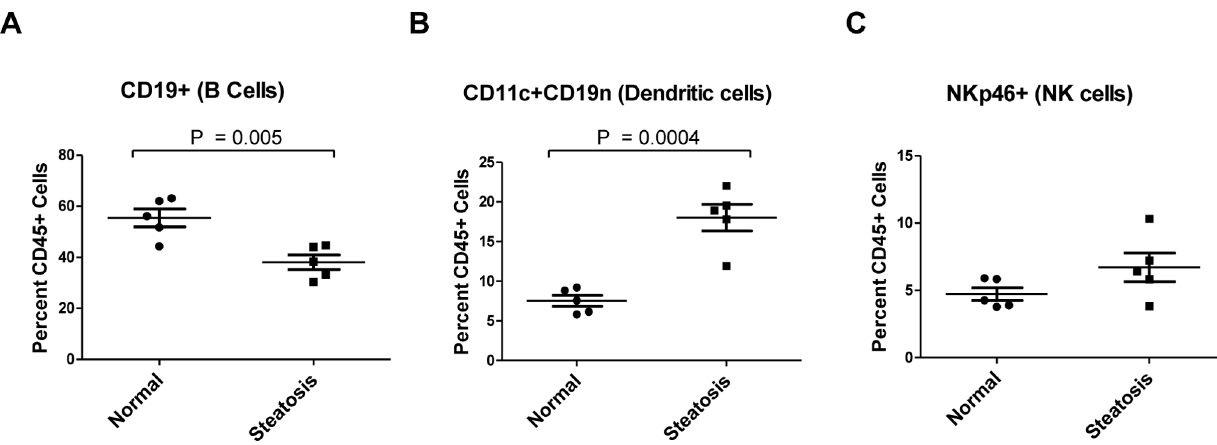
Figure 5. Changes in cell sub-populations of B cells, Dendritic cells and Natural Killer cells in steatotic livers. Isolated CD45 positive cells from normal and steatotic livers were stained for markers for (A) B cells (CD19 + ), (B) dendritic cells (CD11c + , CD19 – ) and (C) natural killers cells (NKp46 + ) before being subjected to flow cytometry and gated as a fraction of CD45 + cells to detect total percentage of subpopulations. Results demonstrate a significant decrease in B cells and a significant increase in total dendritic subpopulations in steatotic murine livers compared to normal livers. Percentage of the overall subpopulation of natural killer cells were not significantly different between groups.